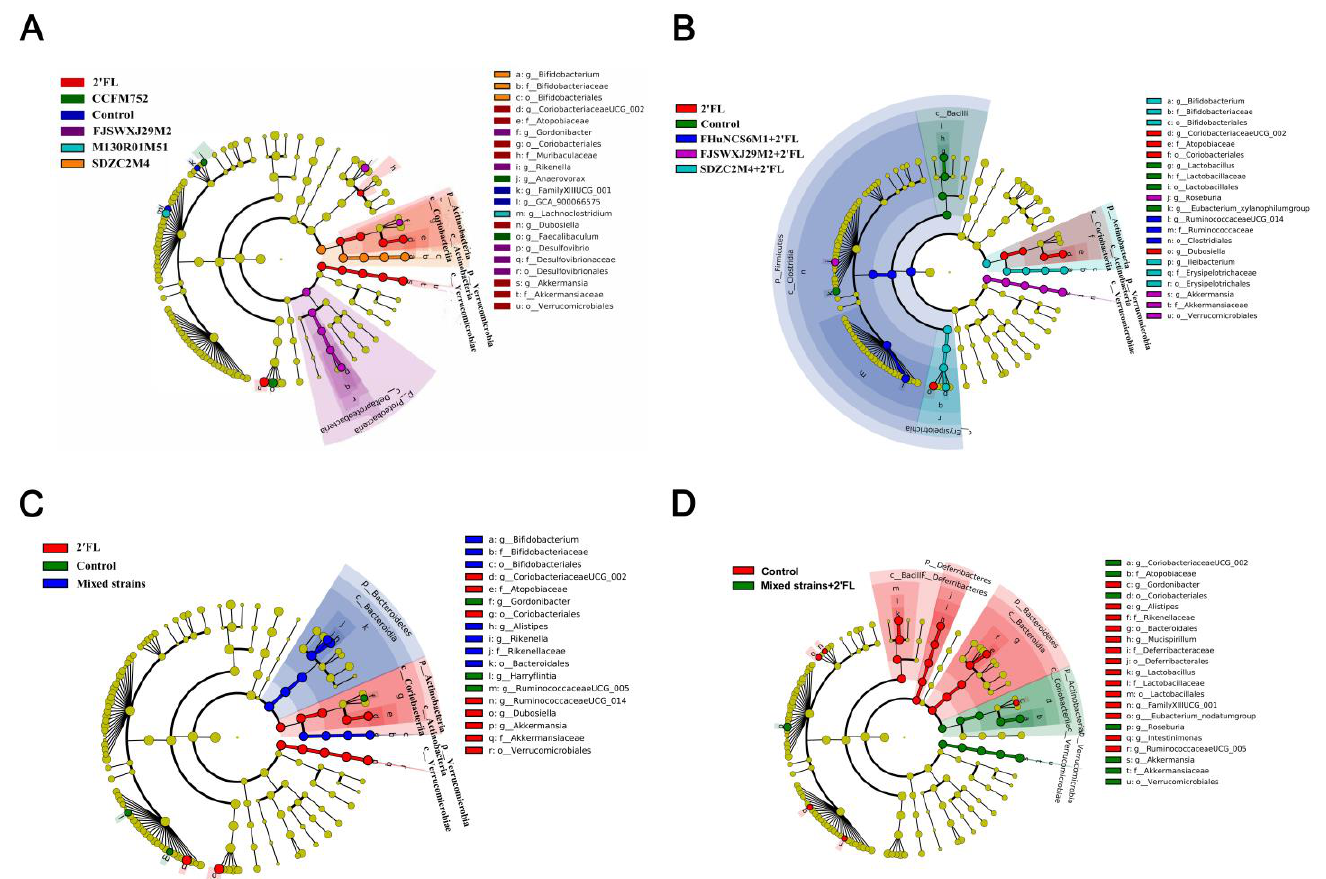
Figure 7. LDA analysis of Bifidobacterium groups ( A ), Bifidobacterium + 2 ′ FL groups ( B ), mixed strains groups ( C ), and mixed strains + 2 ′ FL groups ( D ) (n = 8 for each group).